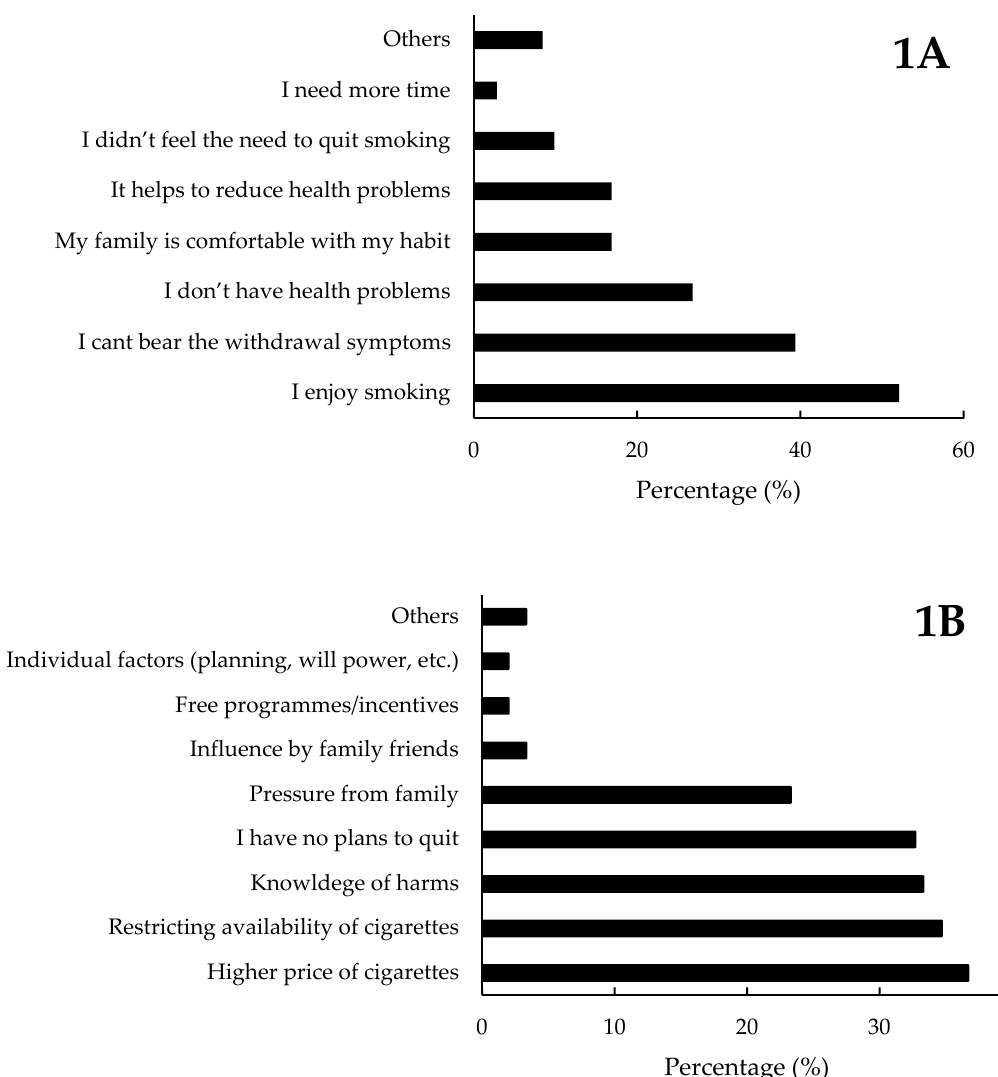
Figure 1. The common reasons cited by current smokers for not having any attempts to quit smoking in the past 12 months ( 1A ) and factors that they felt will encourage smoking cessation ( 1B ).